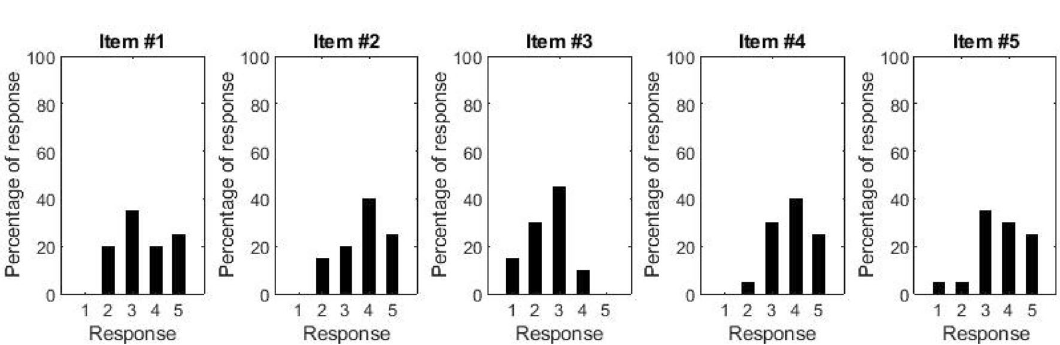
Figure 7. Histograms showing the distribution of responses to the questions about the